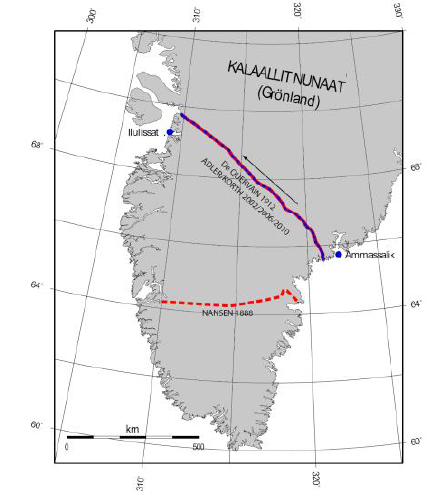
Figure 1. Expeditions - routes of Nansen, Quervain and Korth (according to